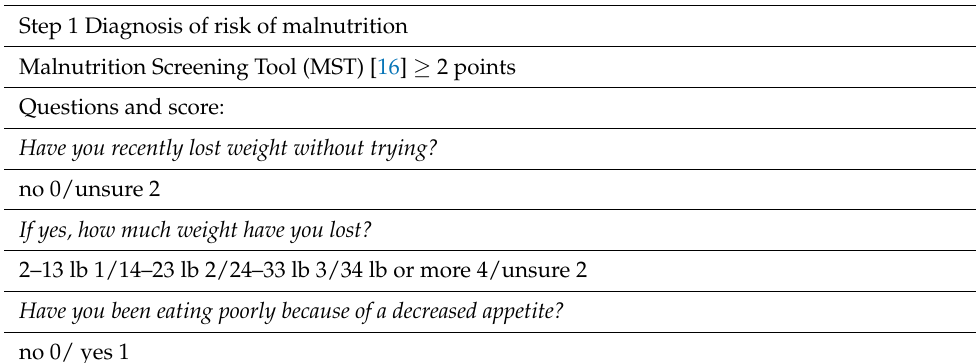
Algorithm 1 Criteria used to diagnose malnutrition based on European Society for Clinical Nutrition and Metabolism (ESPEN) criteria established in 2015